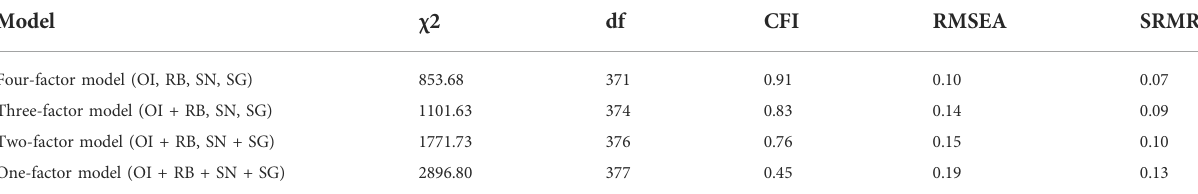
TABLE 2 Variable validity